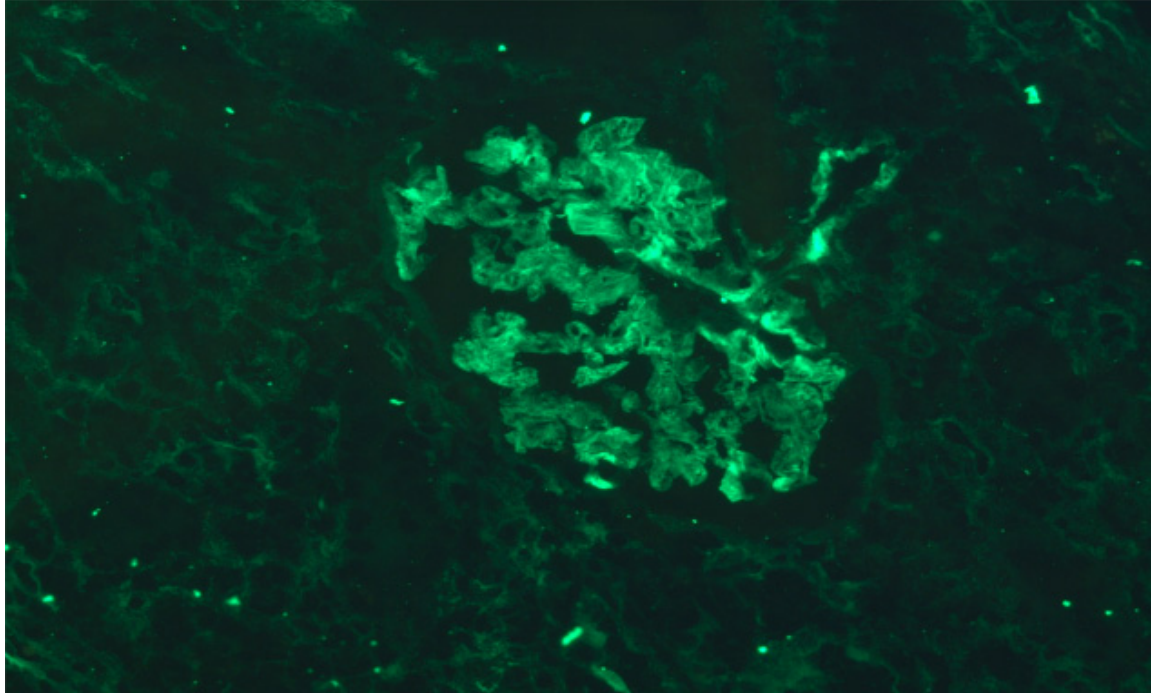
Figure 5. No C4d deposits were found in peritubular capillaries, but there is evidence of antibody interaction with the glomerular epithelium. Indirect immunofluorescence 40×.